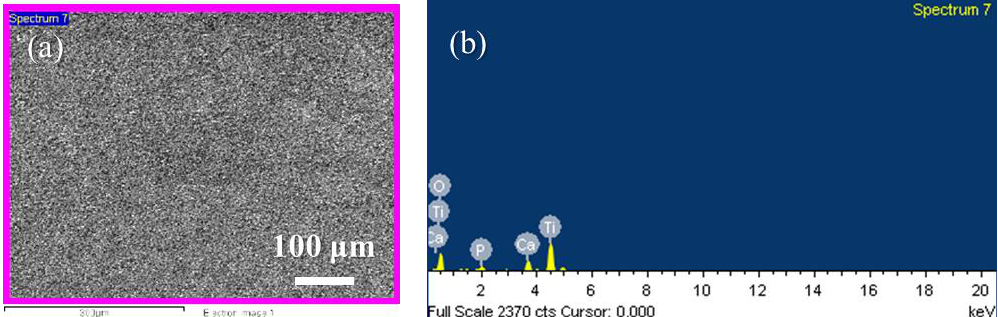
Figure 3. The Energy-Dispersive X-ray Spectrometer (EDS) measurement was performed on the surface of the sample. ( a ) Sample T175_24H_S was scanned in low magnification and ( b ) the EDS spectrum was collected.